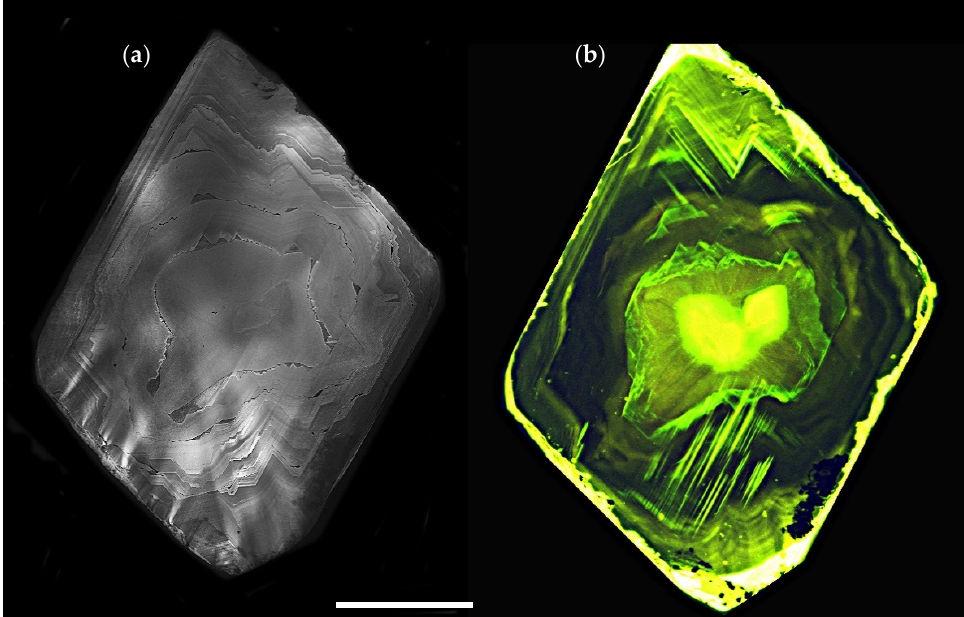
Figure 8. Internal structure of an octahedral diamond crystal after its complete transition from normal to regeneration growth (alternating between these two stages) and subsequent transition to tangential growth: ( a ) CL image and ( b ) PL image. Plate was cut from the center of the crystal in the <110> direction. The scale bar is 2 mm.